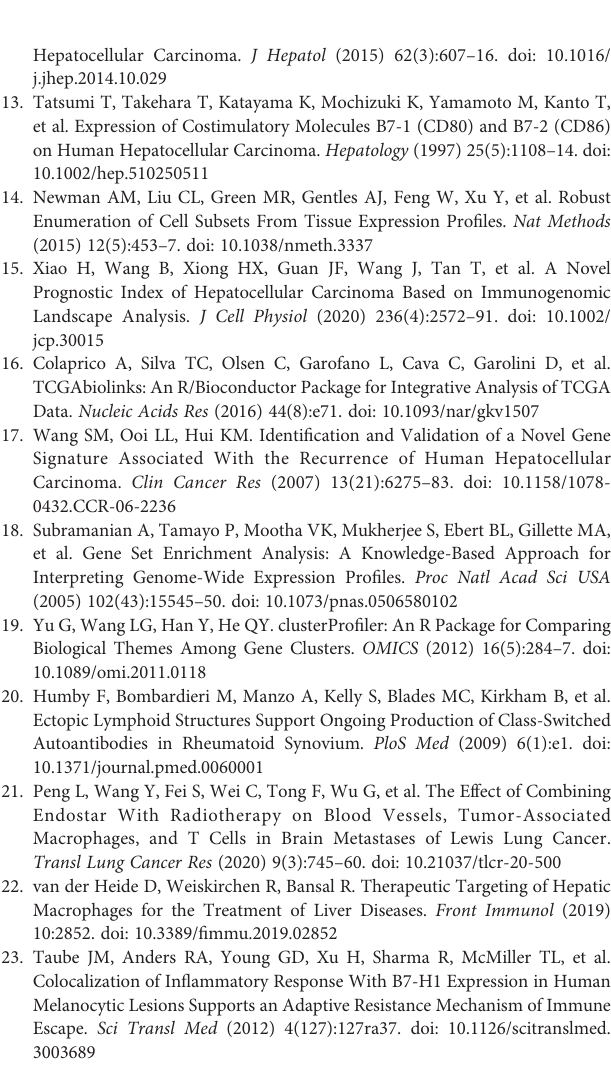
Supplementary Table 1 | Potential pathways related to high and low pIRS